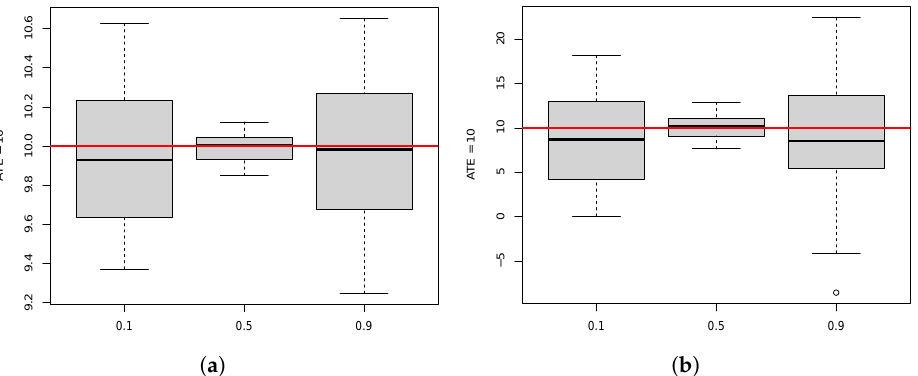
0.1 Figure 8. ATE true = 10 estimations for different participation rates for X-Learner LM method. Note that the scales of the two figures are not the same. ( a ) X-Learner LM: linear. ( b ) X-Learner LM: non-linear.